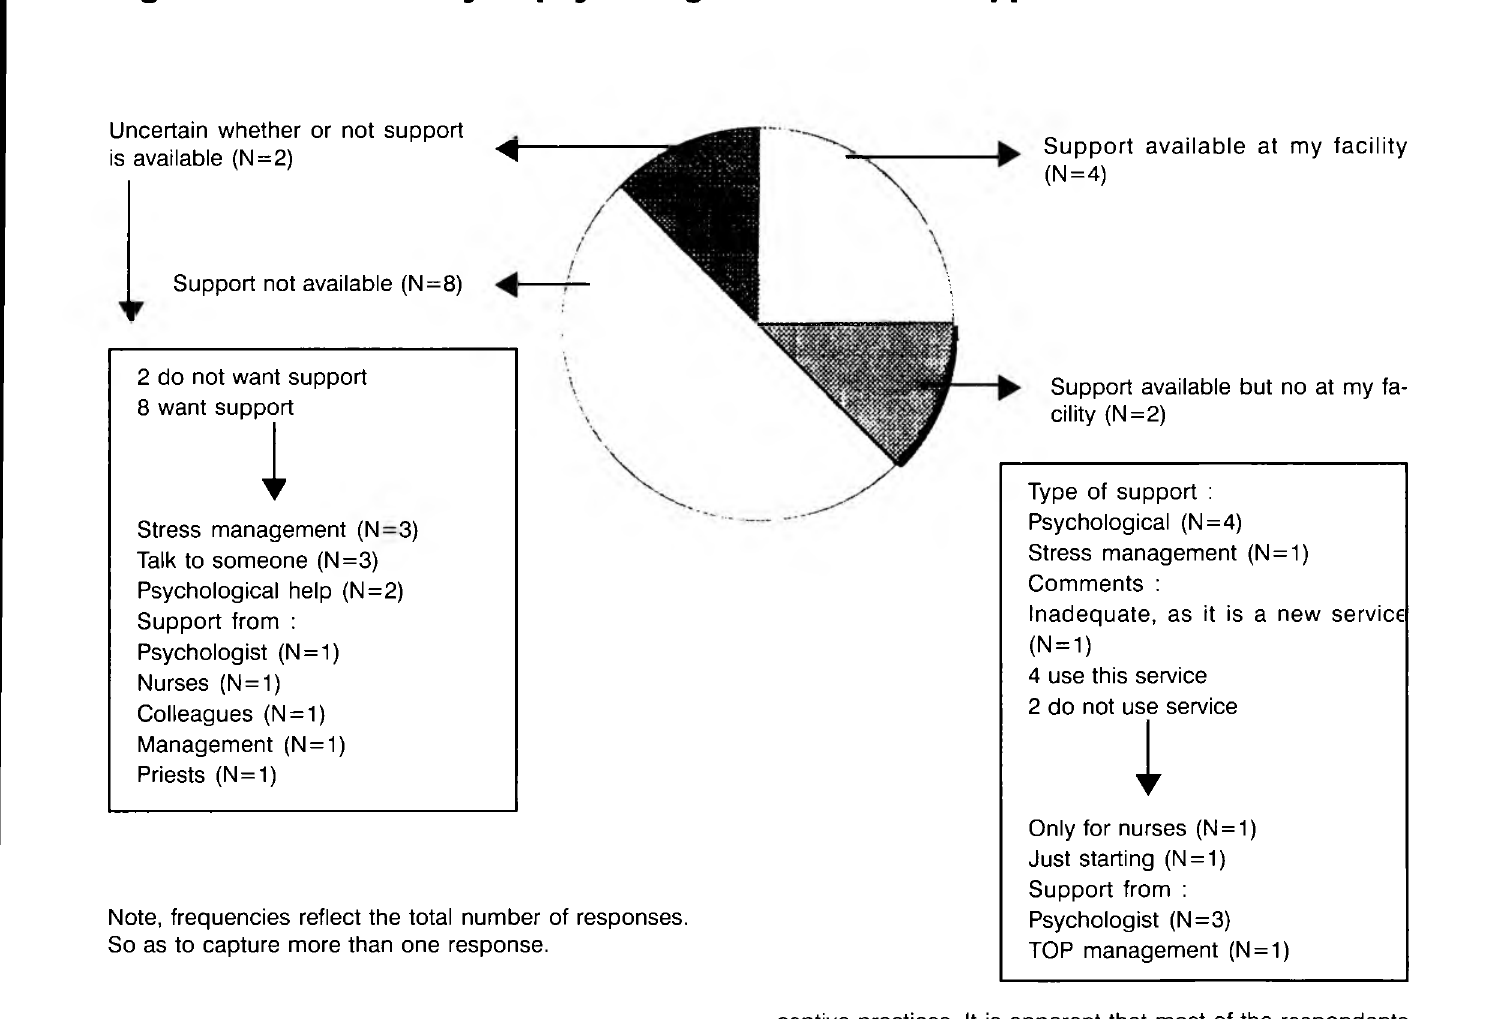
Figure 1 : A vailab ility of psychological/em otional